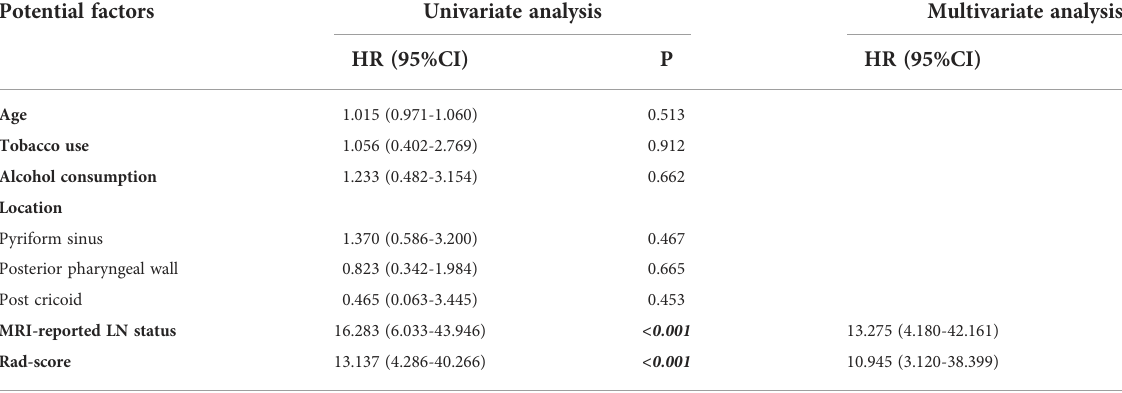
TABLE 3 Analysis of the potential clinical factors of LN metastasis.